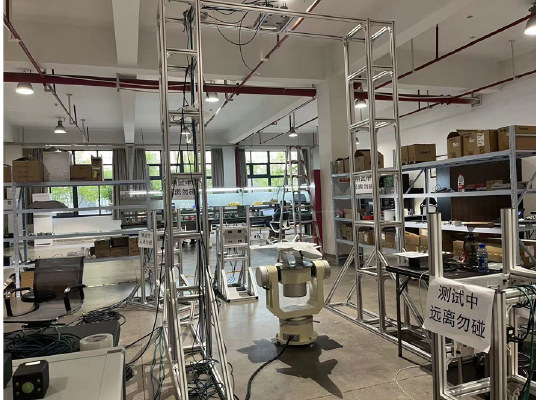
Figure 11. Aircraft pose measurement scenario. Table 4. RANSAC coarse registration results with different feature descriptors and key point extrac- tion methods (average point cloud size: